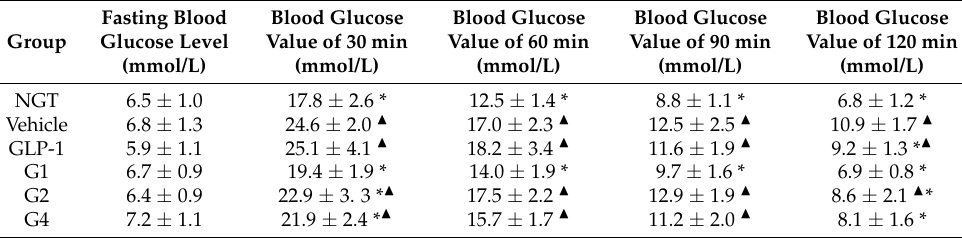
Table A4. The second day’s Glucose tolerance test results (M ± SD, n = 8).